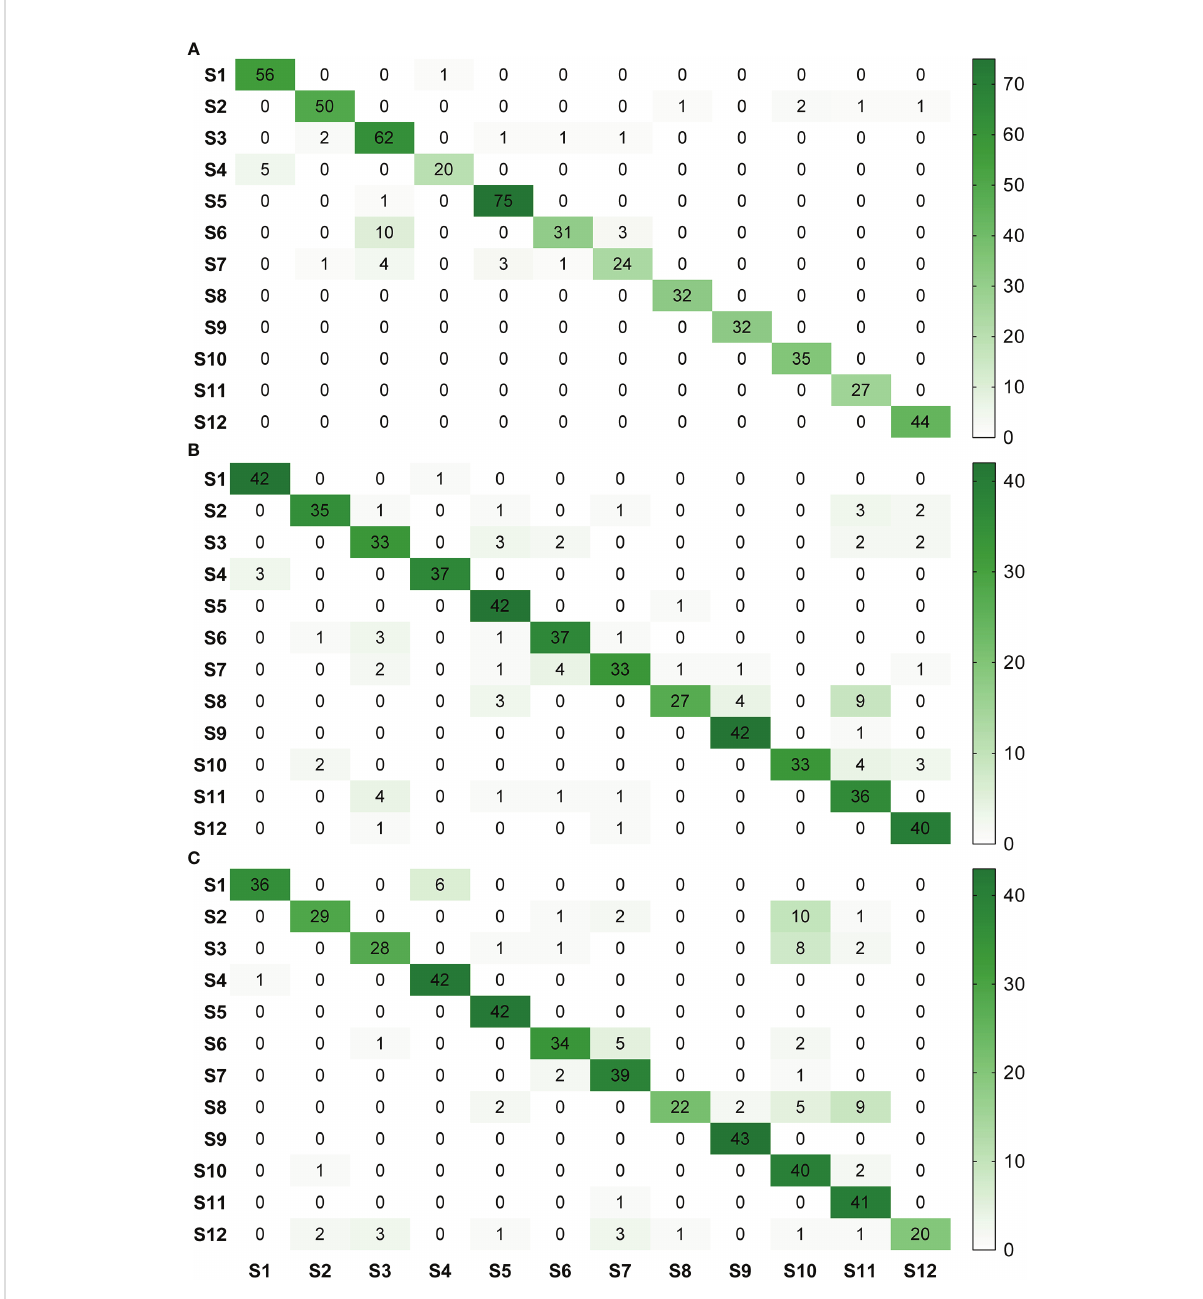
FIGURE 5 Confusion matrices of model HLB2 for recognising images of 12 citrus diseases acquired under different acquisition conditions. (A) , acquisition condition (A, B) , acquisition condition (B, C) , acquisition condition (C) . S1, healthy fruit; S2, healthy leaf; S3, blotchy mottling; S4, “ red-nose ” fruit; S5, zinc-de fi ciency; S6, vein-yellowing; S7, uniform yellowing; S8, magnesium-de fi ciency; S9, boron-de fi ciency; S10, anthracnose; S11, citrus greasy spot; S12, citrus moss. Note: Missed detection is not re fl ected in these matrices. The confusion matrices are given in terms of absolute numbers and not